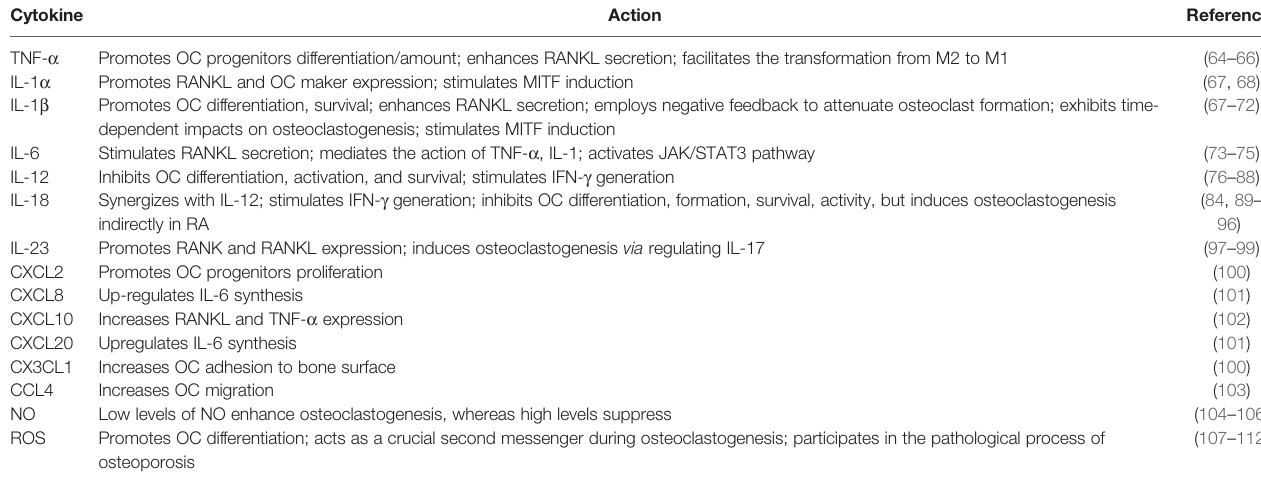
TABLE 1 | Summary of the effects of cytokines produced by M1 macrophage on osteoclasts.